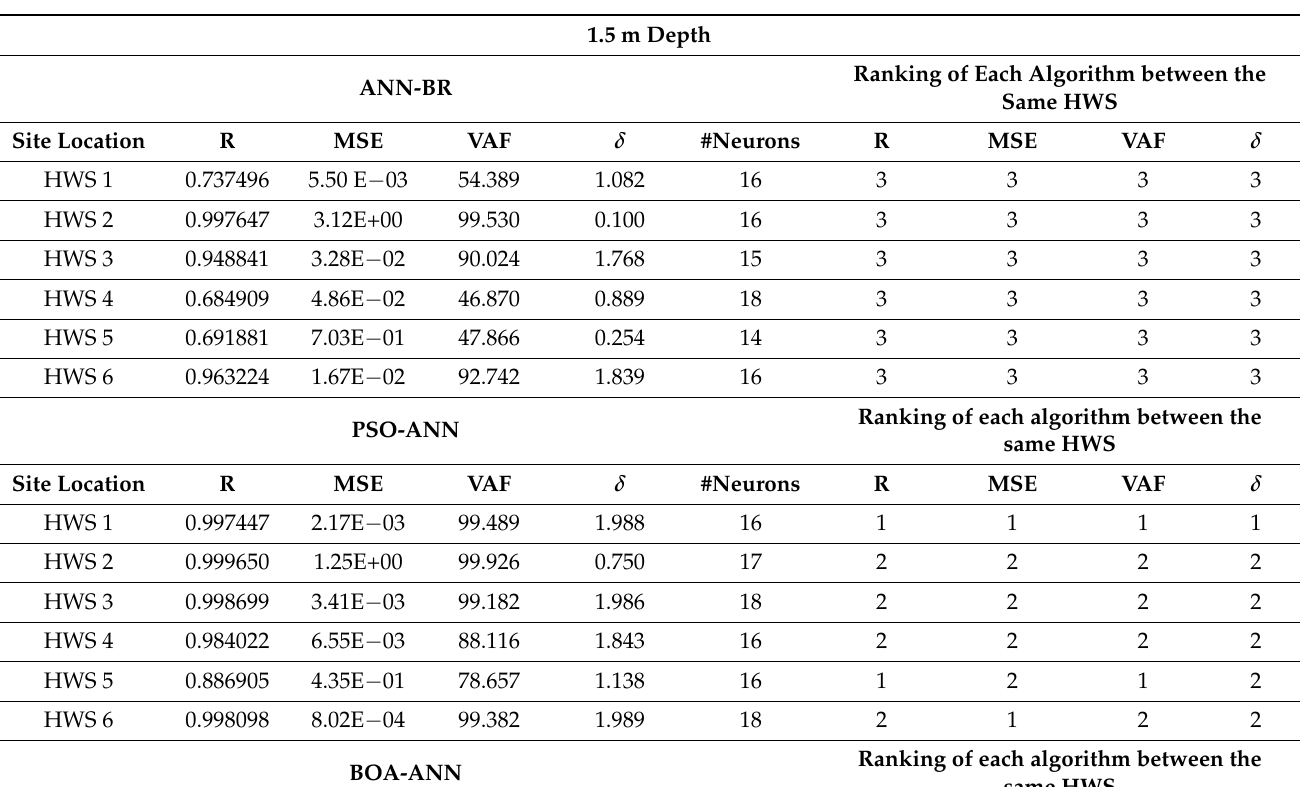
Table 2. Summary of model performance indices and ranks for predictive models at 1.5 m depth.